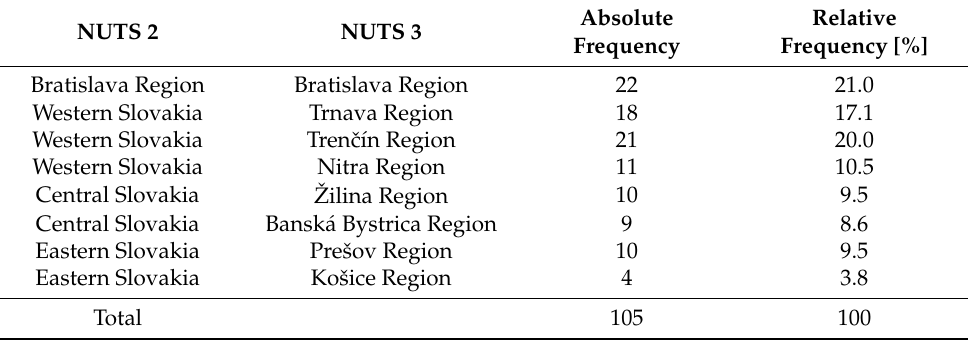
Table 3. Structure of the studied sample by geographical coverage of